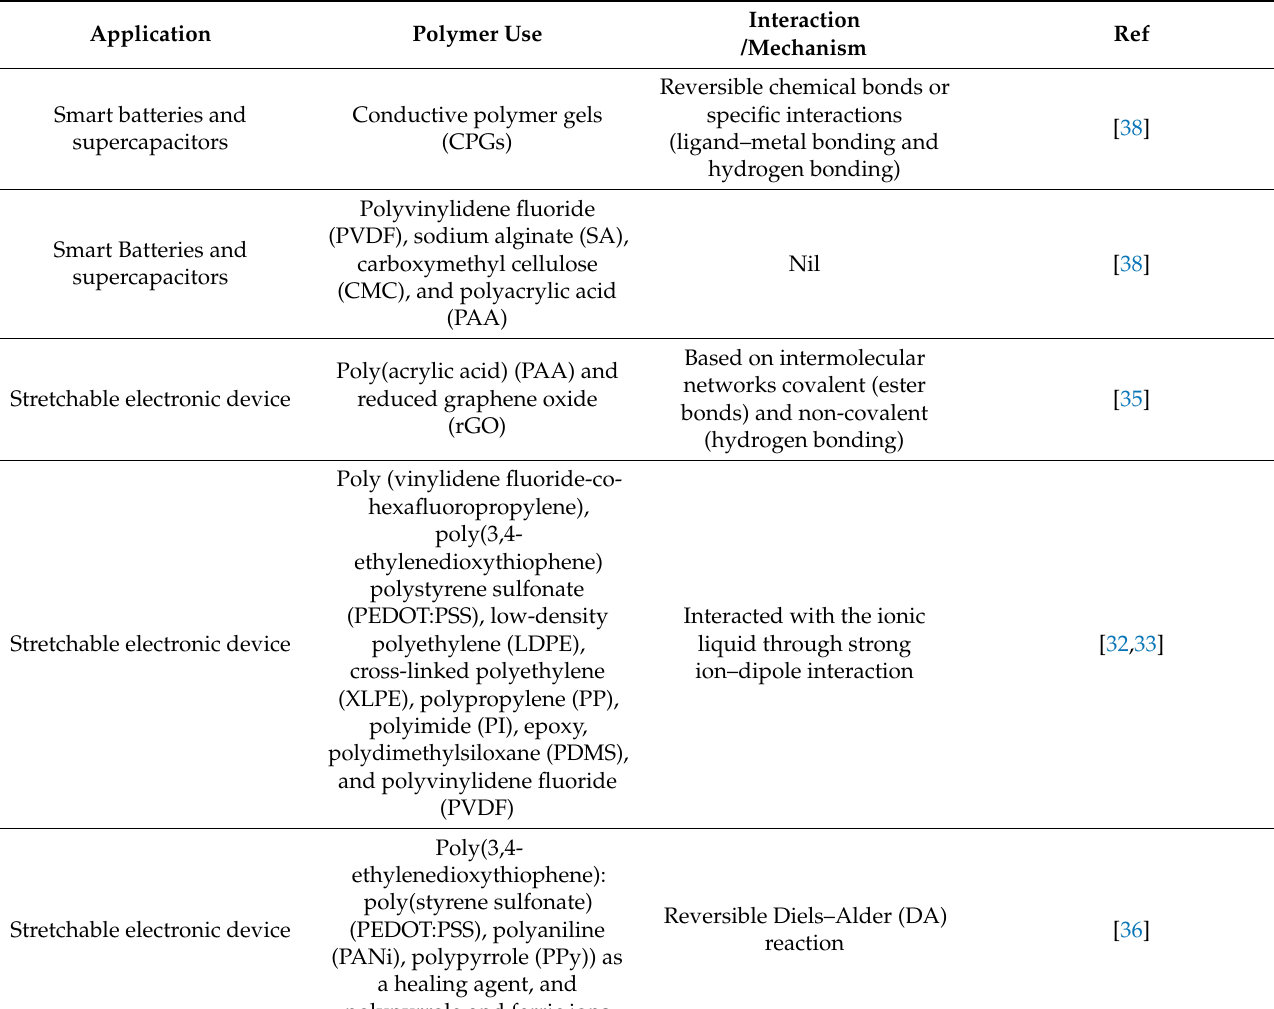
Table 1. Self-healing polymers in electronic